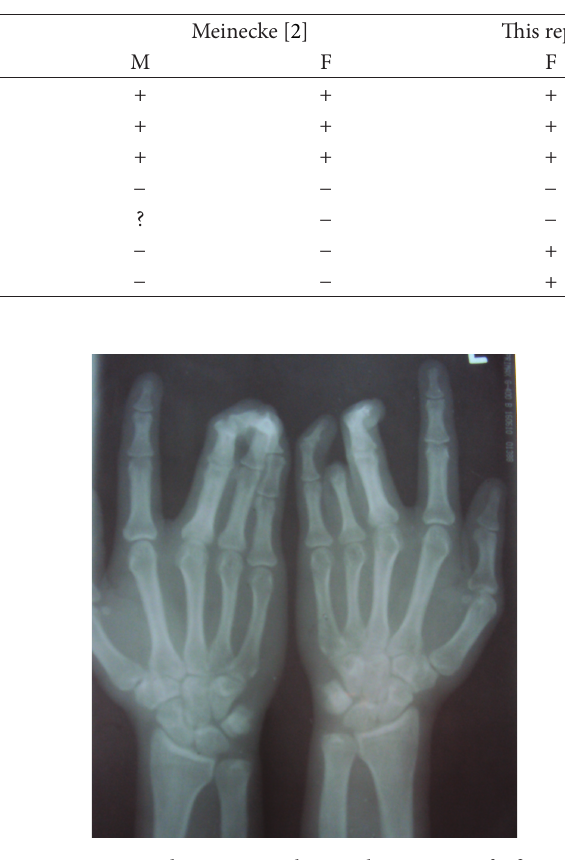
Figure 9: Hand wrist X-ray showing bony union of 3 fingers.